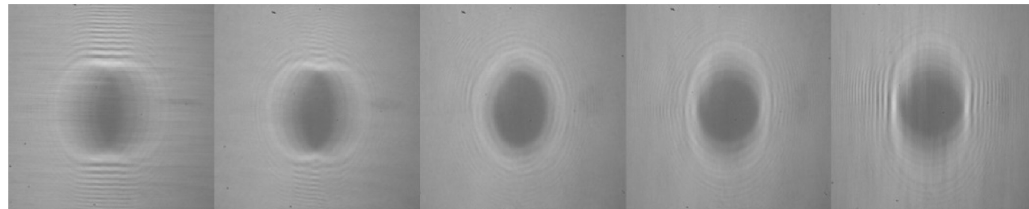
Fig. 2 A series of fuzzy images with varying distances between the microscope and the ring.